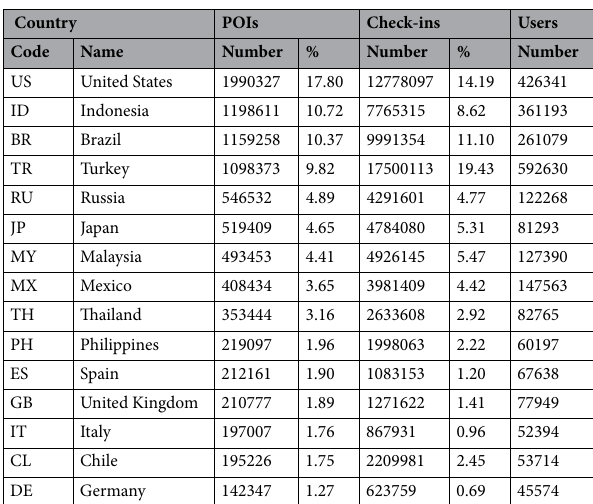
Table 1. Foursquare data set by country. The first 15 countries sorted by the number of points of interest (POI) are shown, as well as the number of check-ins, users, and the percentage of the total dataset that